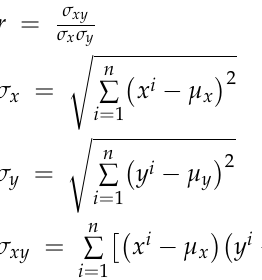
Figure 5. Grid for the possible locations of SV.